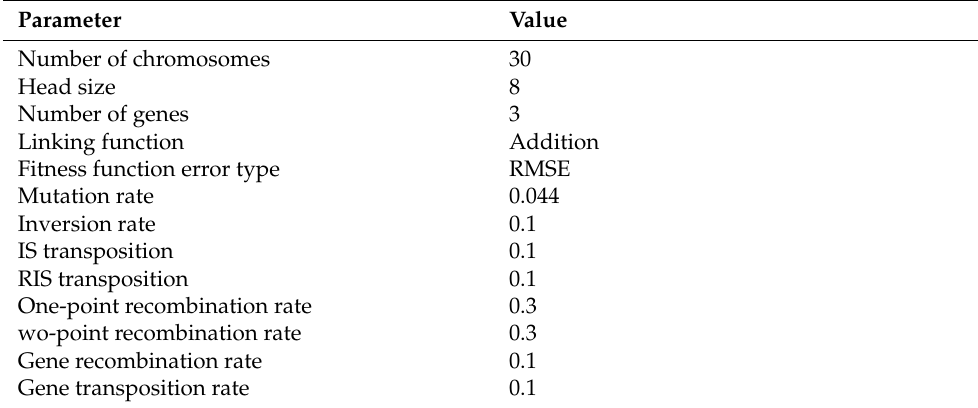
Table 6. Used parameters in gene expression programming